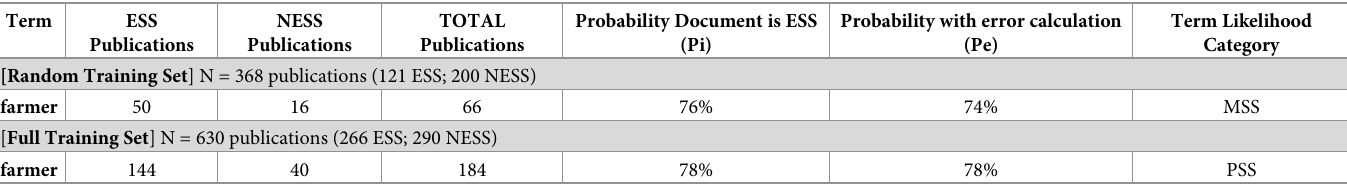
Table 4. Term frequency script results for the term